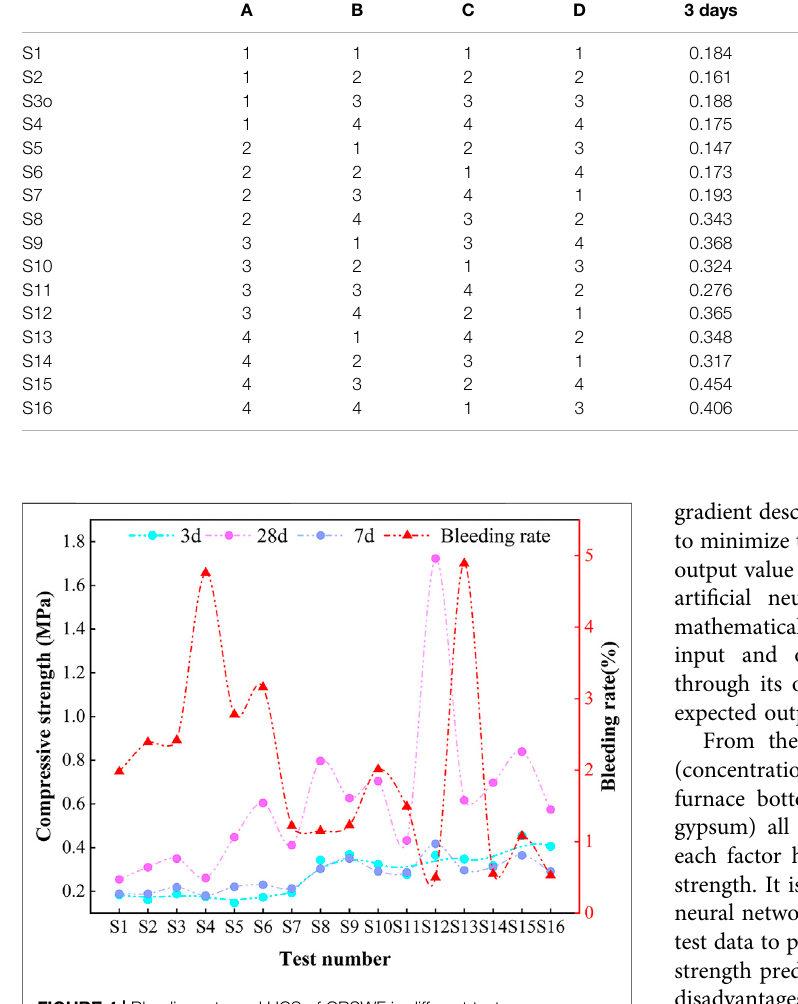
FIGURE 4 | Bleeding rate and UCS of CBSWF in different test